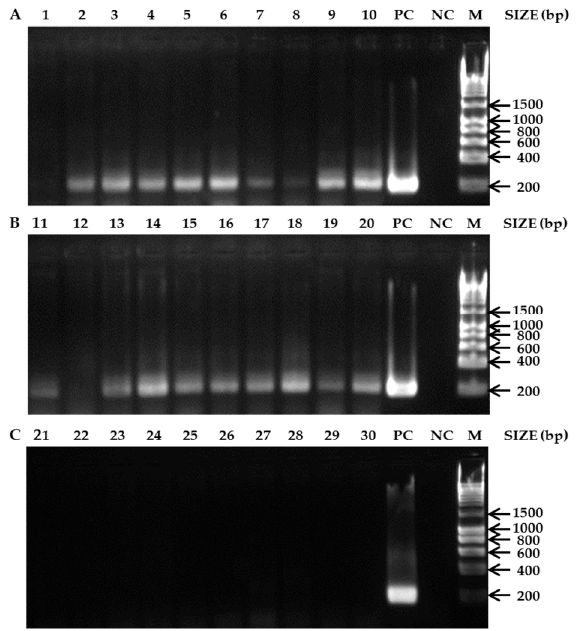
Figure 2. Agarose gels of PCR products. (A) Non-infested A. mellifera colonies from Nigeria based on visual screening; (B) SHB-infested A. mellifera colonies from Nigeria based on visual screening. (C) SHB-free A. mellifera colonies from Switzerland. 1. A. mellifera colonies (Ile-Ife); 2. A. mellifera colonies (Otan-Ile); 3. A. mellifera colonies (Lampese); 4. A. mellifera colonies (Logbara); 5. A. mellifera colonies (Tilden fulani); 6. A. mellifera colonies (Gubi); 7. A. mellifera colonies (Sarkin Pawa); 8. A. mellifera colonies (Kaltungo); 9. A. mellifera colonies (Kumo); 10. A. mellifera colonies (Rano); 11. A. mellifera colonies (Idi-Isin); 12. A. mellifera colonies (Ibule-Soro); 13. A. mellifera colonies (Ibule-Soro); 14. A. mellifera colonies (Ota); 15. A. mellifera colonies (Ota); 16. A. mellifera colonies (Logbara); 17. A. mellifera colonies (Logbara); 18. A. mellifera colonies (Itagbere); 19. A. mellifera colonies (Gubi); 20. A. mellifera colonies (Bebeji); 21. A. mellifera colonies (Aare 1); 22. A. mellifera colonies (Aare 2); 23. A. mellifera colonies (Aare 3); 24. A. mellifera colonies (Aare 4); 25. A. mellifera colonies (Liebefeld 1); 26. A. mellifera colonies (Liebefeld 2); 27. A. mellifera colonies (Liebefeld 3); 28. A. mellifera colonies (Liebefeld 4); 29. A. mellifera colonies (Liebefeld 5); 30. A. mellifera colonies (Liebefeld 6); PC = Positive control; NC = Negative control; M = Molecular marker (HyperLadder™ (Bioline Reagents Limited, London, UK) 1kb).